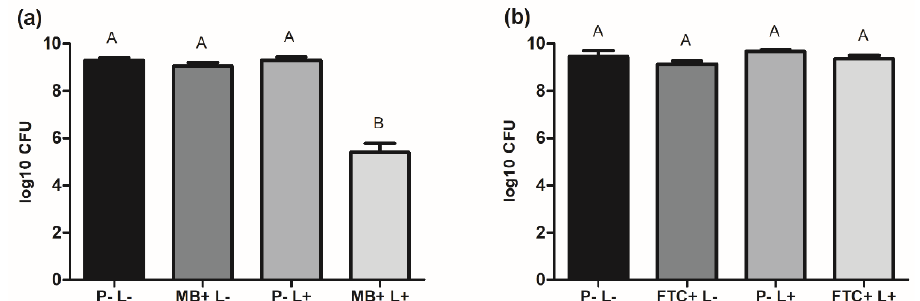
Figure 2 . Means and standard deviation of viable cells of A. baumannii (log 10 CFU) in biofilms for the following groups: absence of photosensitizer and light (P-L-), FTC without light (FTC+L-), MB without light (MB+L-), absence of photosensitizer with light (P-L+), FTC with light (FTC+L+), and MB with light (MB+L+). ( a ) Experiment performed to test the photosensitizer MB. ( b ) Experiment performed to test the photosensitizer FTC. ANOVA and Tukey test: different letters represent statistical difference between the groups ( p ≤ 0.05).